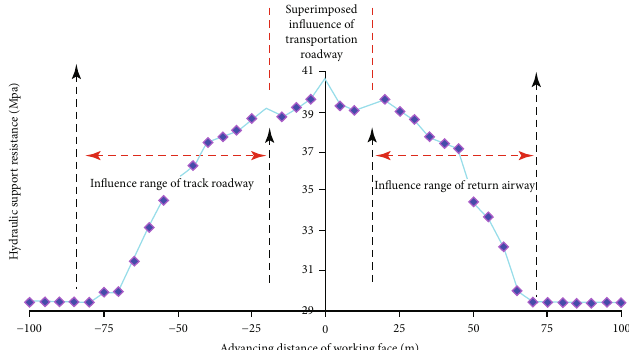
Figure 14: Support resistances when the working face is pushed to di ff erent positions in the abandoned